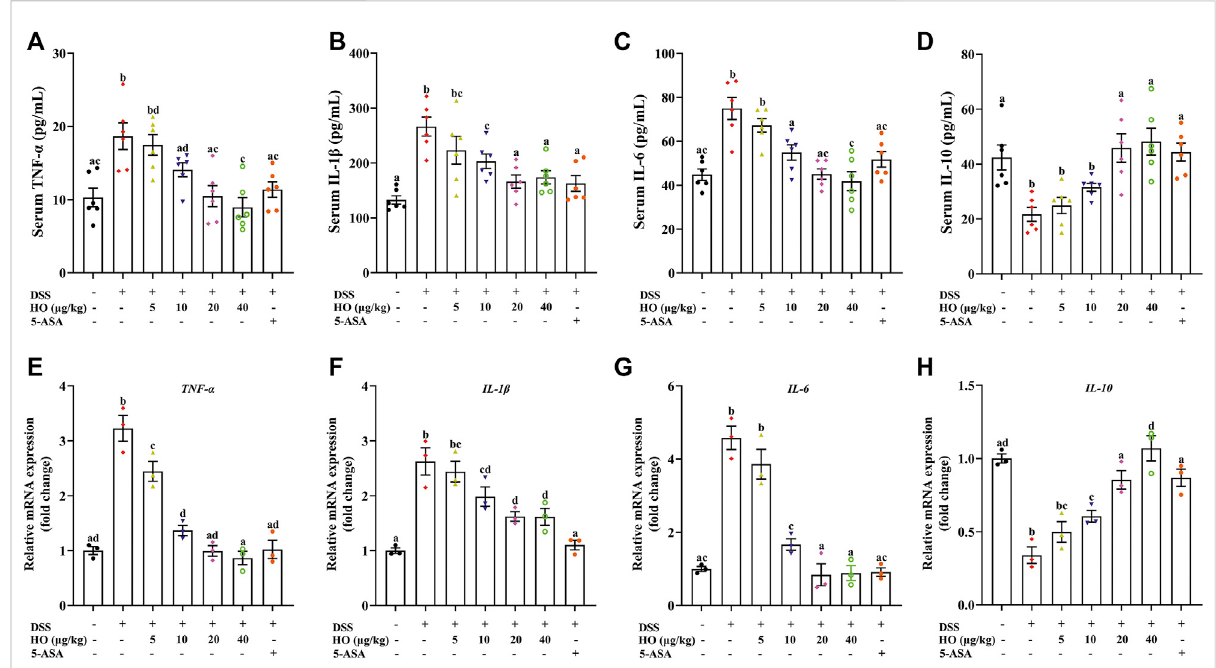
Microscopic scoring is assessed based on the criteria for histological damage parameters. Values are expressed as mean ± S.E.M. ( n = 6). Different letters in the same column represent signi fi cant differences between groups by Fish ’ s LSD test ( p < 0.05). HO, human opiorphin; DSS, dextran sulfate sodium.